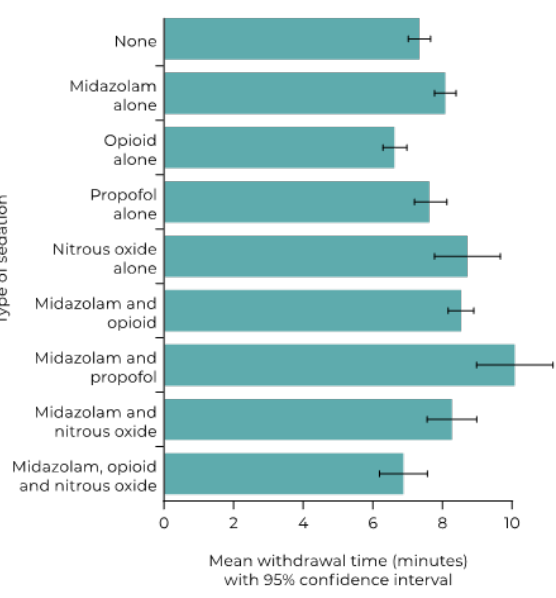
Figure 4. Mean withdrawal time (minutes) according to type of sedation used. Table 3. Proportion of procedures with a withdrawal time greater than 10 min according to type of sedation (combinations with a frequency <10 were excluded from analysis).